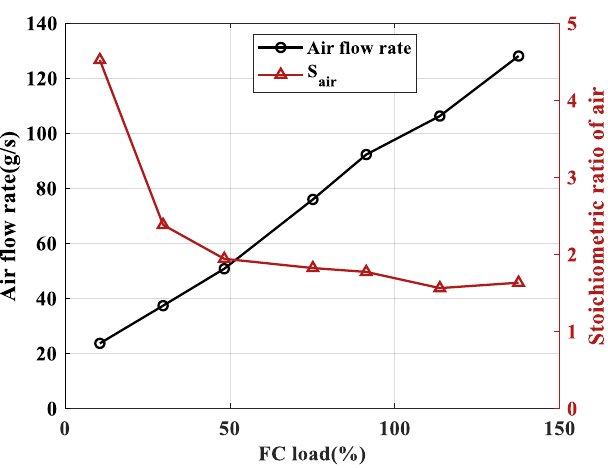
Figure 6. Air flow rate and air stoichiometric ratio under different fuel cell loads.